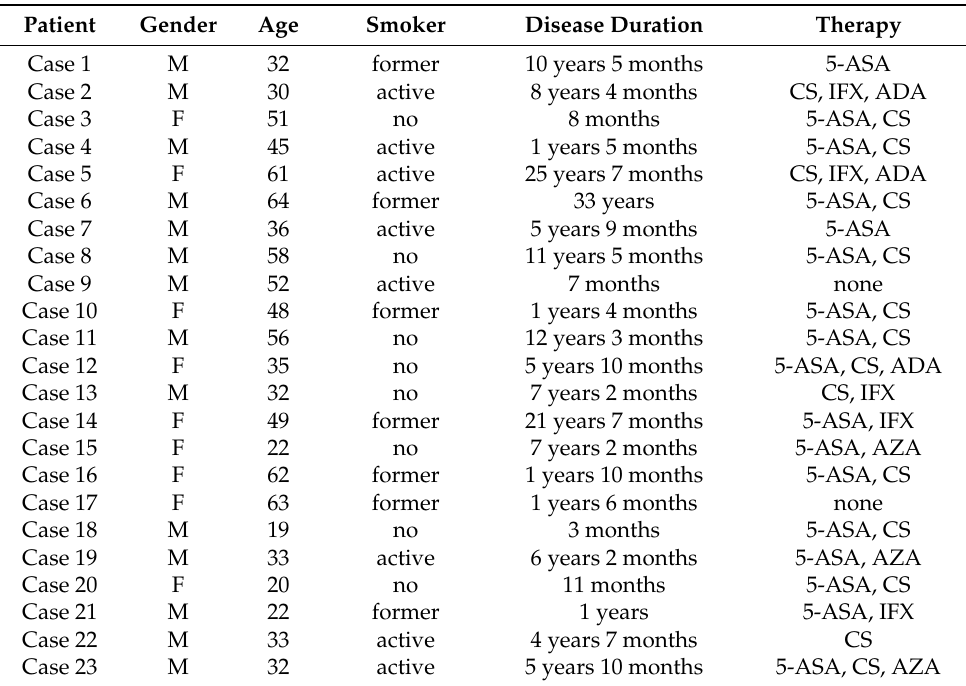
Table 2. Demographic data and medical